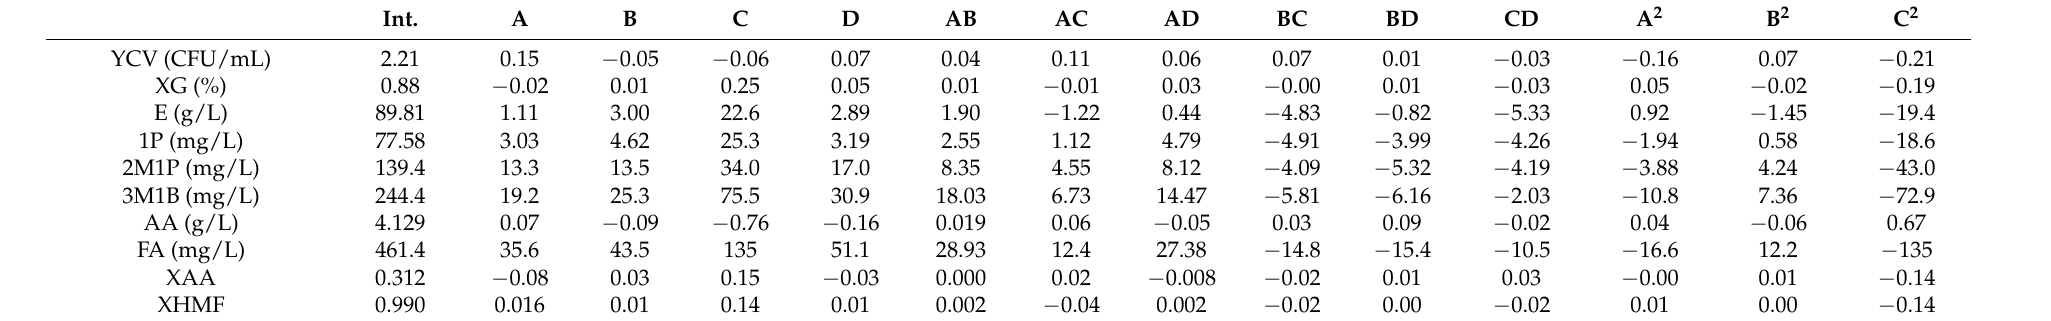
Table 5. Equation terms of coded factors. pH (A), stirring (B), temperature (C), hydrolysis (D).